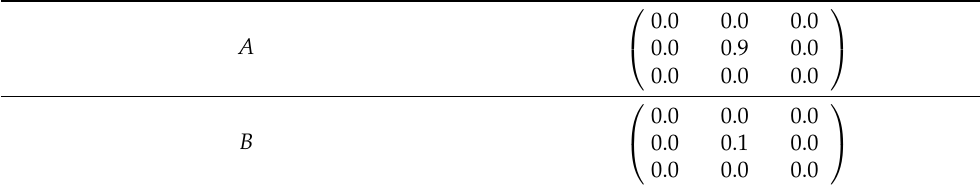
Table 5. Coefficients for the input and output weights in Equation (24) for the case of the image store setup.